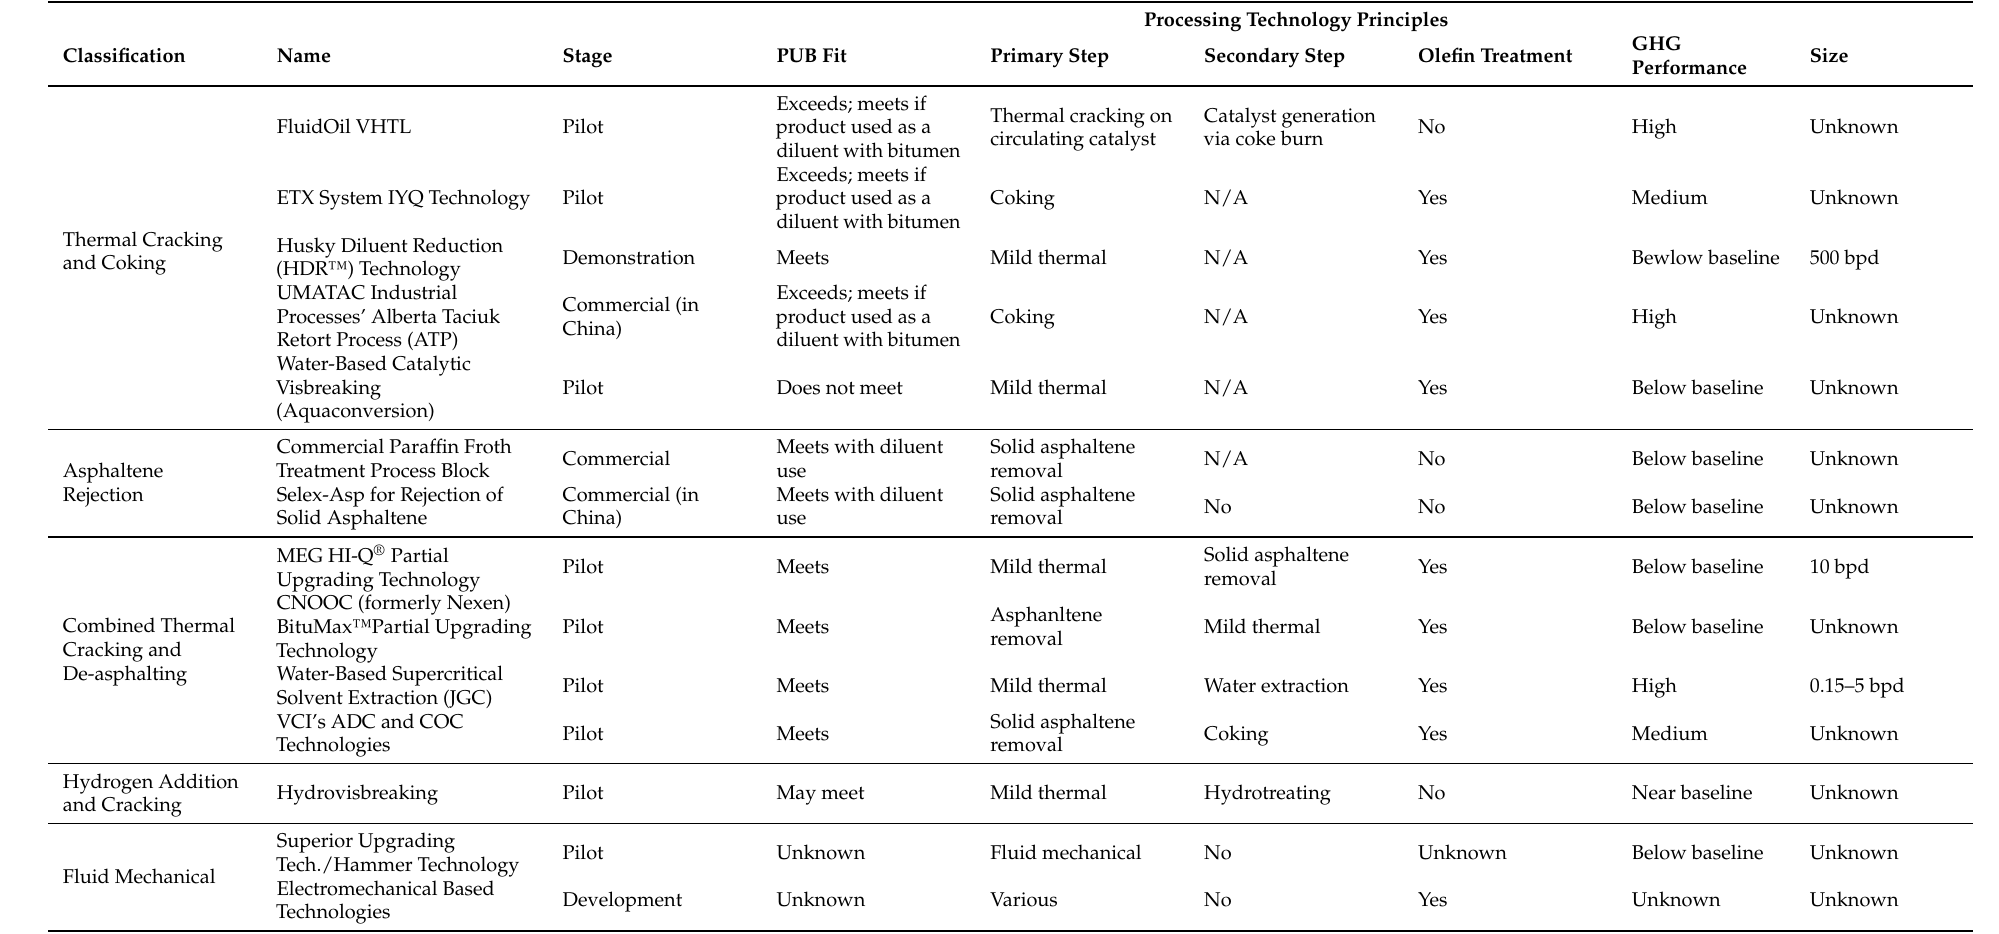
Table 1. Partial Upgrading Technologies and